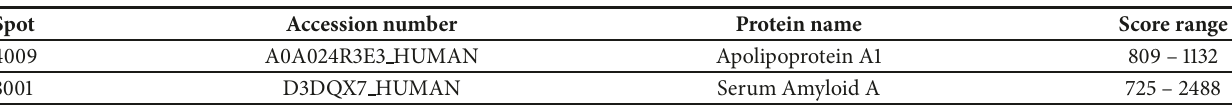
Table 2: Proteins of interest identified by LC-MS/MS. The MASCOT server performed the match analysis and the search of proteins using Uniprot Human database. According to that, spot 4009 is apolipoprotein A1 and 8001 is serum amyloid A.